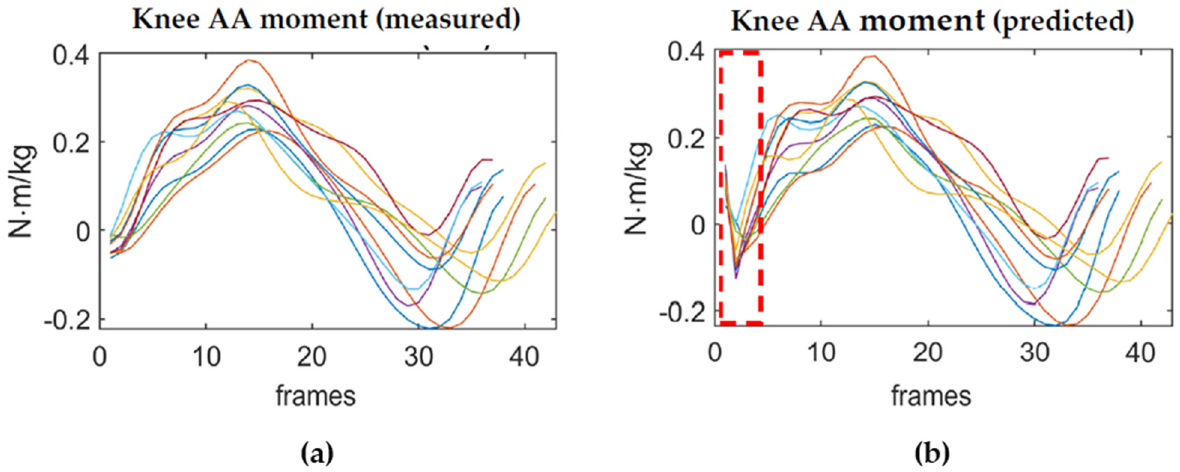
Figure 12. Adduction/abduction moments. ( a ) Measured right knee AA moment; ( b ) Predicted right knee AA moment. Each curve corresponds to a jump performed by a subject and as it can be noticed, the prediction errors accumulated at the beginning of the curves, in the part enclosed by the dotted rectangle.